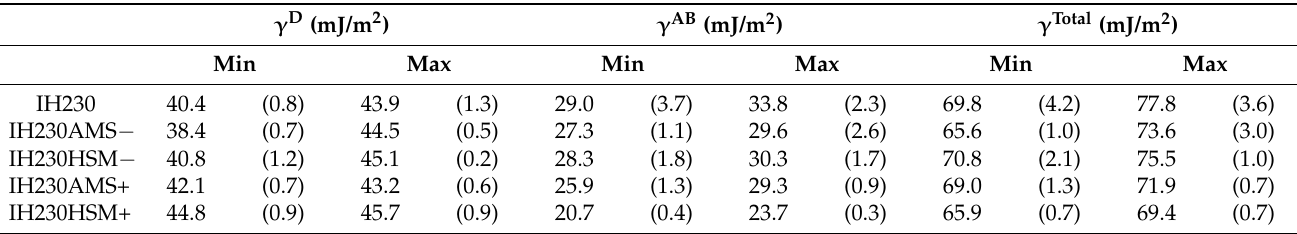
Table 4. Results of the SE determination of the raw material in comparison to processed powders with and without the additive. n = 3, SD in